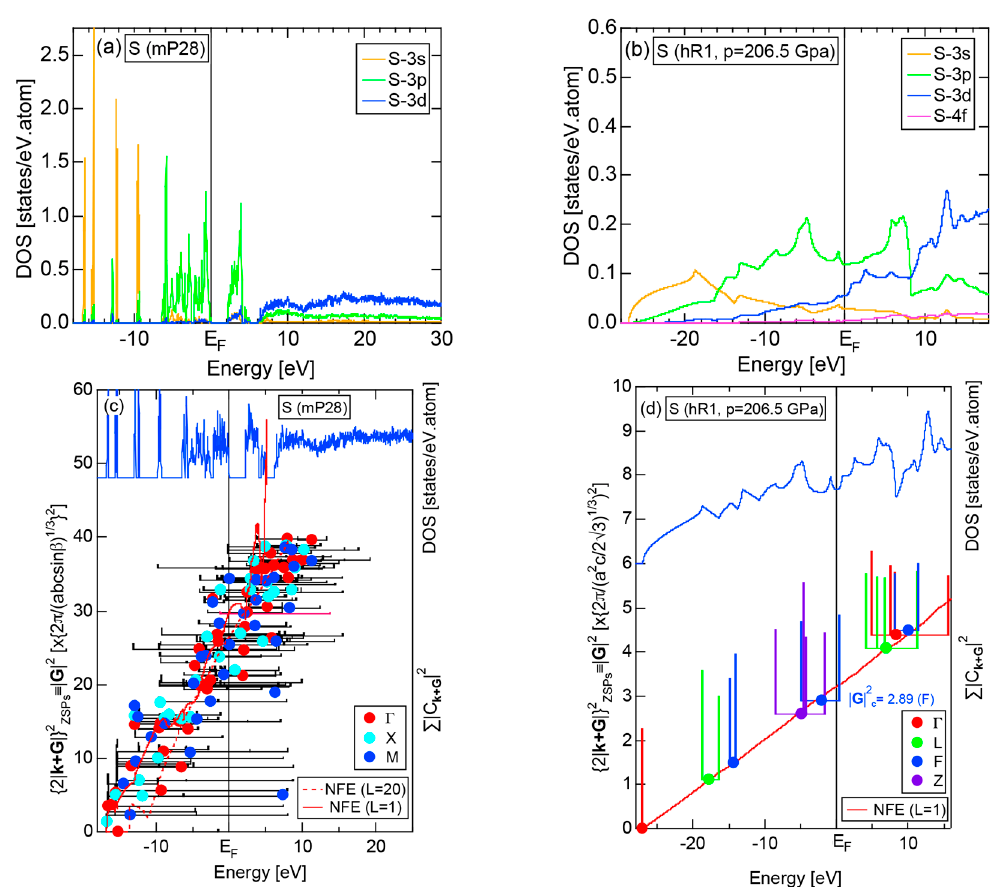
Figure 13. Partial DOSs for ( a ) insulating S (mP28) at ambient conditions and ( b ) metallic S (hR1) synthesized under high pressures P = 206.5 GPa [11]. FLAPW-Fourier spectra at symmetry points Γ , X and M of the Brillouin zone for the monoclinic lattice for ( c ) insulating S (mP28) and those at symmetry points Γ , L, F and Z of the Brillouin zone for the rhombohedral lattice for metallic S (hR1).